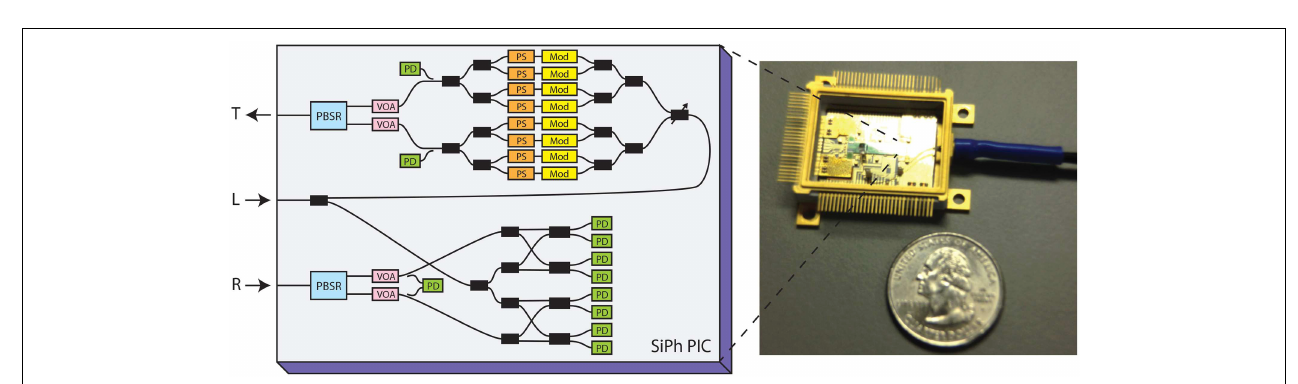
FIGURE 25 | Single-chip silicon photonic coherent